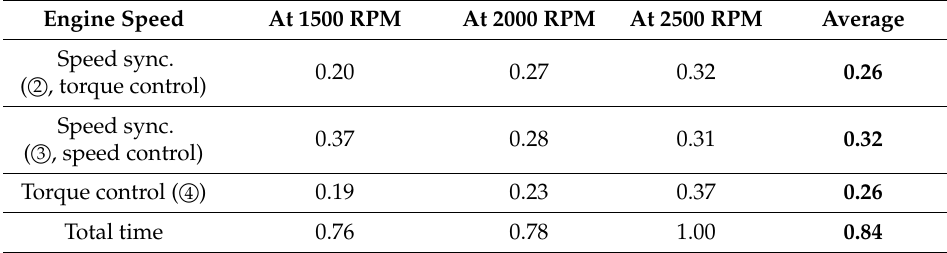
Table 3. Elapsed times for shifting from odd to even gear-stage (from 1st to 2nd) (Unit: second). Engine Speed At 1500 RPM At 2000 RPM At 2500 RPM Average Speed